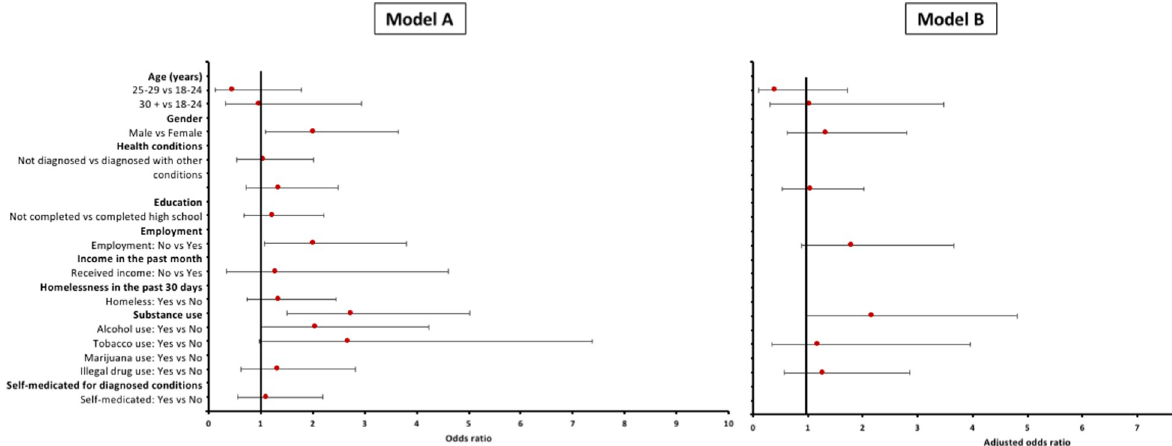
Fig 2. Odds ratios showing the association of each variable on diversion among PLWH in the eThekwini district. Model A represent the odds ratios showing the association of each variable on diversion among PLWH in the eThekwini district. All variables were fitted in the model, including geographical setting, to assess their collective association on the outcome for Model B. Model B represents adjusted odds ratios showing the association of a group of variables on diversion among PLWH in the eThekwini district.